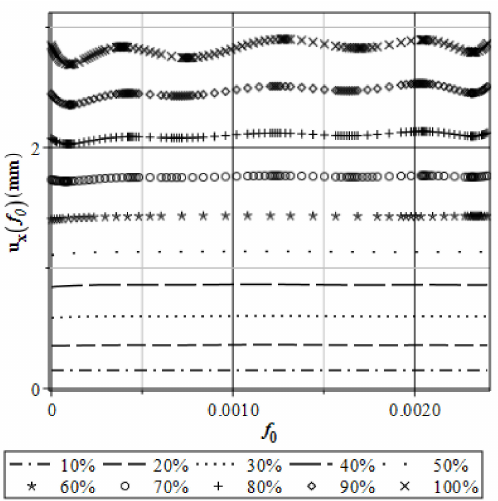
Figure 5. Response function polynomials of displacements as a function of f 0 .